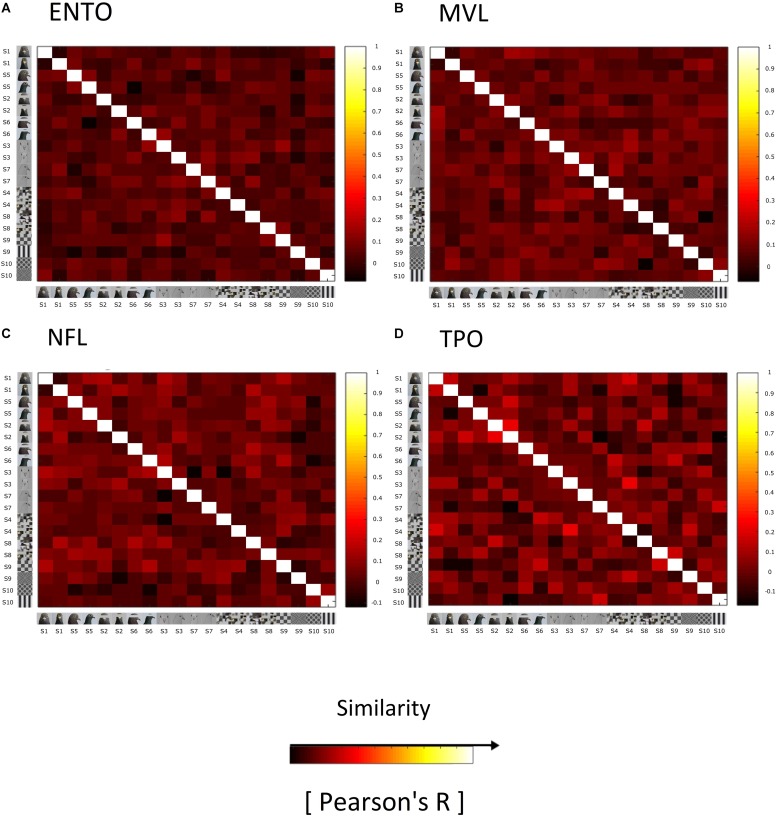
Representational similarity matrices (RSM) showing the similarity of responses elicited by the stimuli for all visually responsive neurons in (A) ENTO, n = 65, (B) MVL, n = 37, (C) NFL, n = 28, and (D) TPO, n = 11. The similarity of responses for each stimulus is measured as Pearson correlation across space (Pearson’s R), averaged across all sessions for each region. The colour code reflects the similarity of spatial correlations (see colour bar; +1 being total similarity, 0 for no correlation, and –1 as total anticorrelation) computed separately for each RSM (for R-values and their histograms). The Bob and Larry examples of individual stimuli are organised into Face (S1, S5, S2, S6, S3, and S7) and Non-Face (S4, S8, S9, and S10) categories along the rows of the matrix. RSM analysis failed to demonstrate a clustering of strong correlations for faces relative to non-face stimuli in ENTO, MVL, NFL, or TPO, in contrast to the face-representation exhibited in monkey and human IT Cortex (Kriegeskorte et al., 2008b).